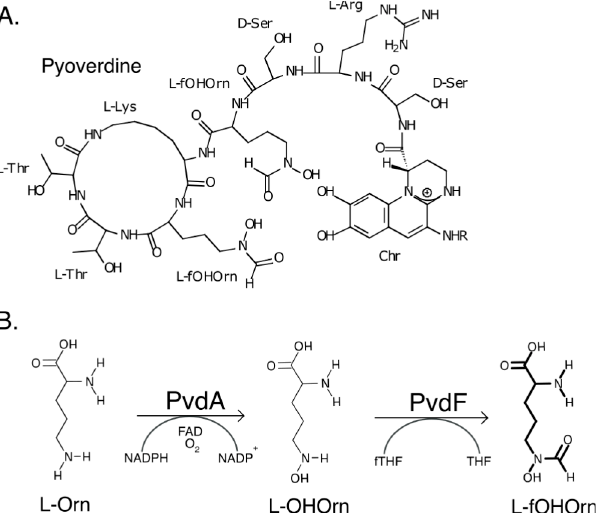
Figure 1. Pyoverdine structure and synthesis of formylhydroxyornithine. ( A ) Pyoverdine from P. aeruginosa PAO1. ( B ) Synthesis of formylhydroxyornithine (fOHOrn) from L -ornithine ( L -Orn). PvdA catalyses hydroxylation of L -Orn to L -OHOrn which is then formylated by PvdF with N 10 - formyltetrahydrofolate (fTHF) as the co-substrate to give L -fOHOrn and tetrahydrofolate (THF).